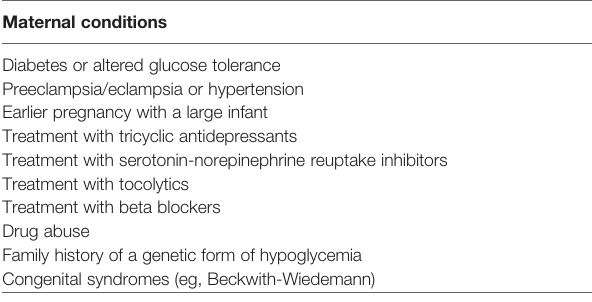
TABLE 3 | Risk factors associated with